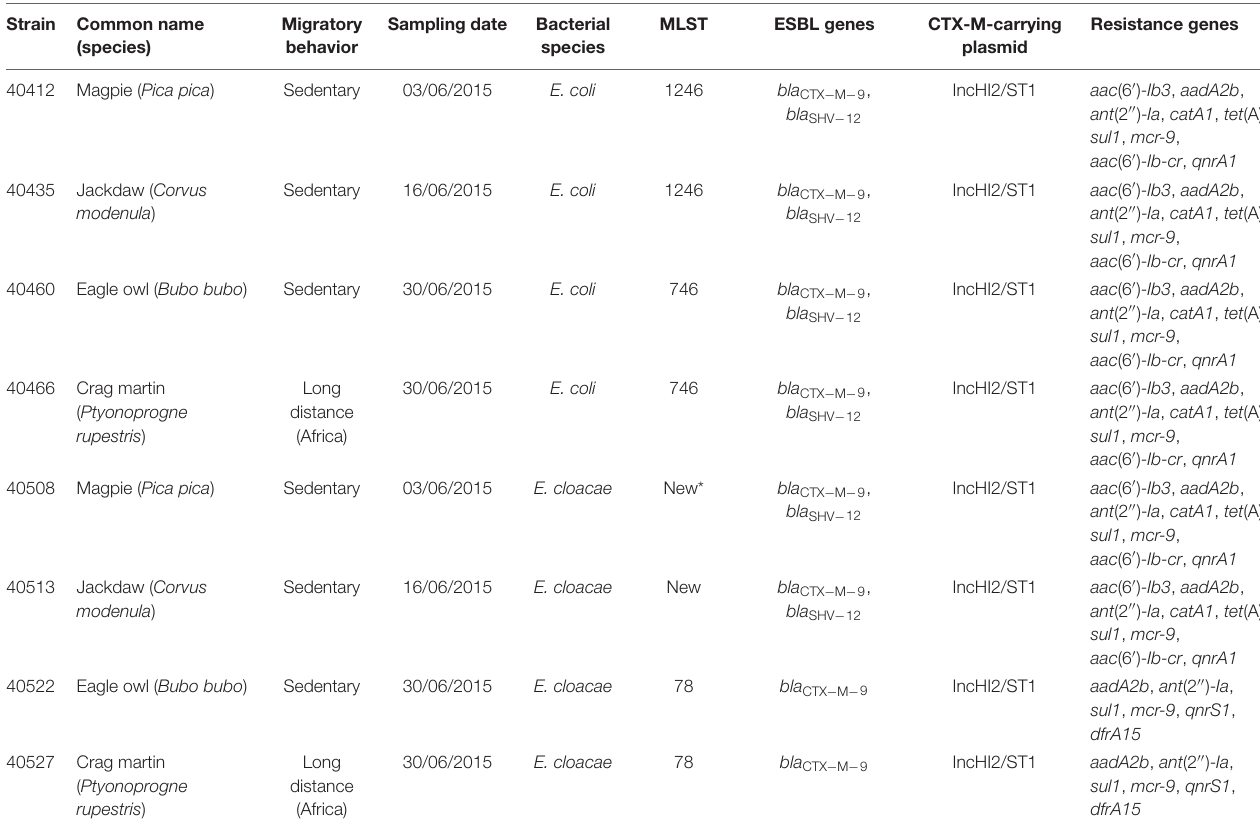
TABLE 4 | Epidemiological and molecular features of the eight isolates that were fully sequenced. Strain Common name